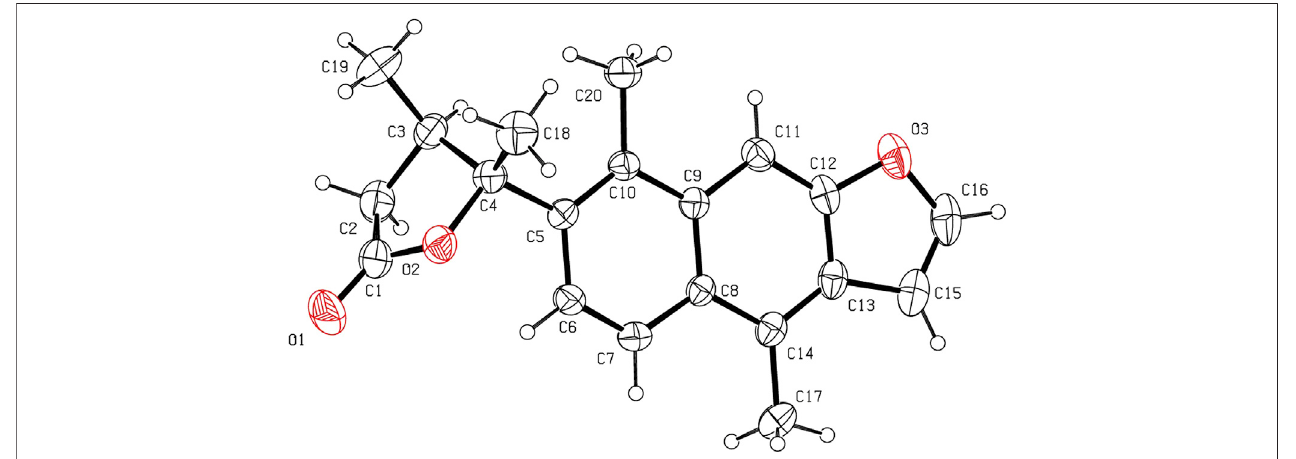
FIGURE 4 | ORTEP plot of the X-ray crystallographic structure for 1 (displacement ellipsoids were drawn at the 30% probability level).